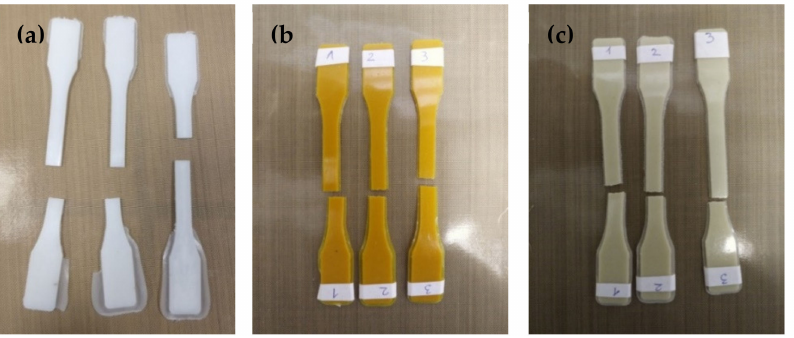
Figure 9. Fittings produced by injection molding method, samples after breaking on a testing machine: ( a ) PCL, ( b ) PCL + 20(1), and ( c ) PCL +